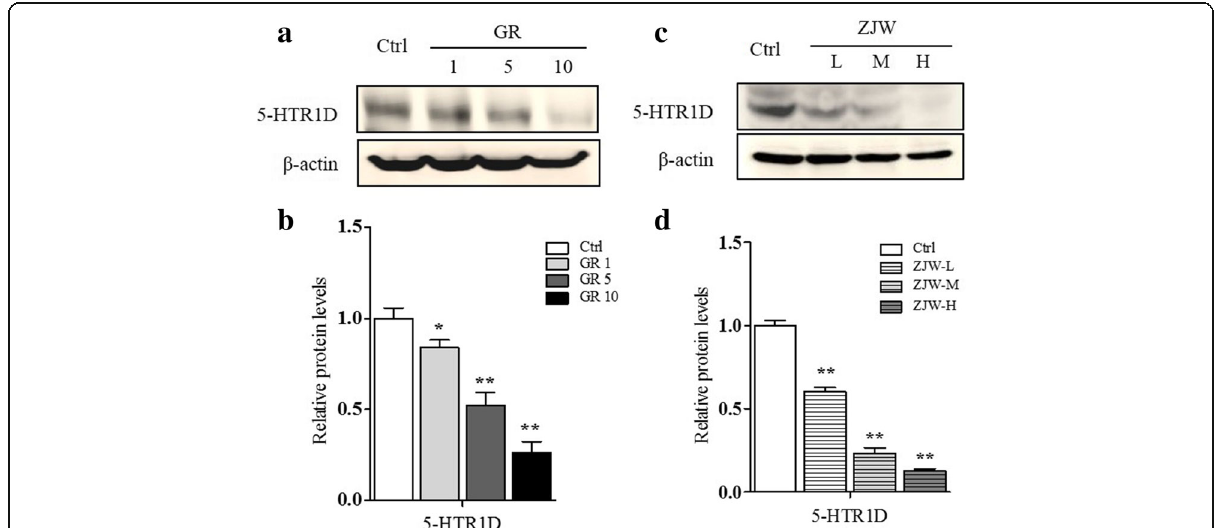
Fig. 1 Effect of the ZJW extracts treatment on 5-HTR1D expression in SW403 cell. SW403 cell was stimulated with GR (1, 5, 10 μ mol/L) and ZJW at low, medium, and high dose, respectively. Cells were cultivated for 24 h. Protein expression in cells with different stimulation was determined by Western blot. Results were normalized to β -actin expression. a Representative western blots of 5-HTR1D protein in GR-treated SW403 cells. b The corresponding semi-quantification data of ( a ). c Representative western blots of 5-HTR1D protein in ZJW-treated and GR (5 μ mol/L)-treated SW403 cells. d The corresponding semi-quantification data of ( c ). All values are shown as mean±SD of three separate experiments, and significant values are indicated with asterisks (* P <0.05, ** P <0.01 vs.